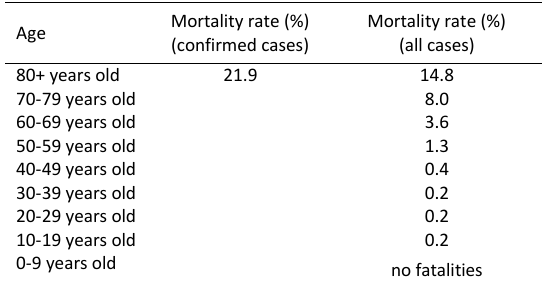
add up to 100%, as they do not represent the share of deaths by age group.